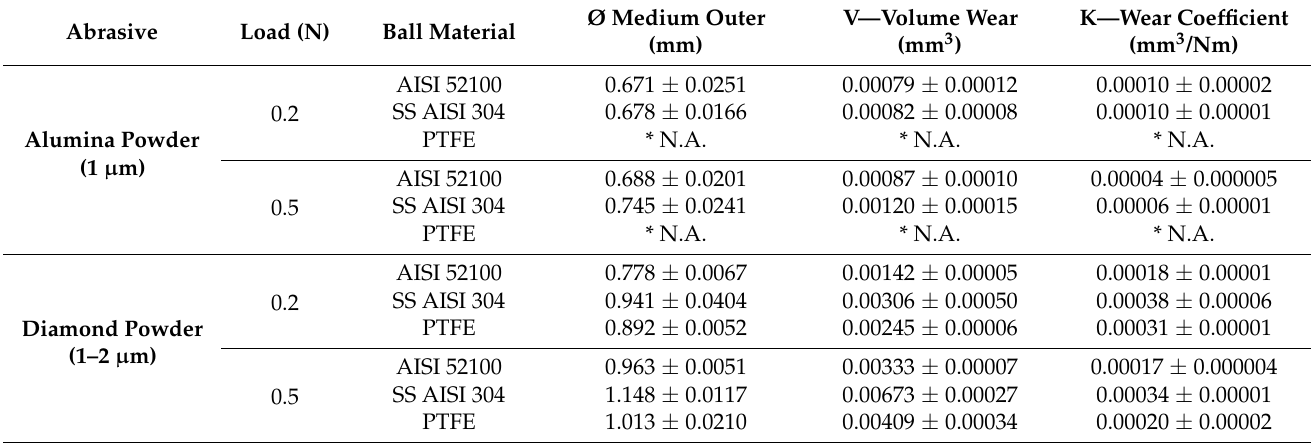
Table 1. Crater diameter according to the average size of the abrasive particles and ball material using 0.2 and 0.5 N as normal